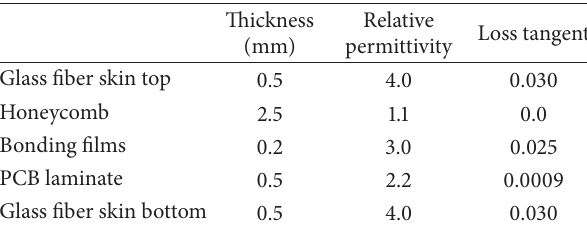
Table 1: The thicknesses and material parameters of the CLAS.